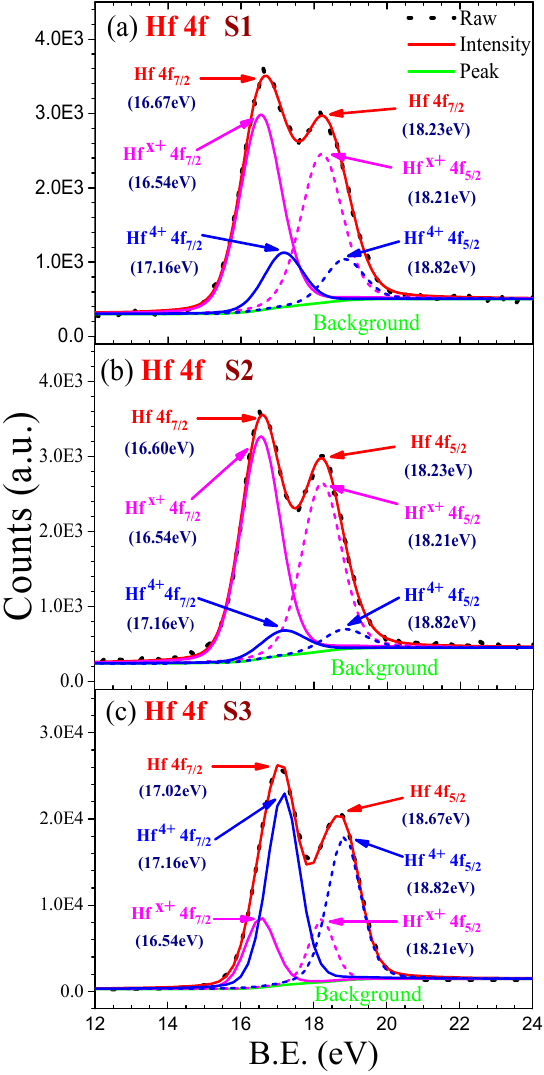
Figure 2. The high-resolution XPS fitting results of the Hf 4f peaks of S1, S2, and S3 are shown in ( a – c ), respectively, with experiment data (short dash lines), fitting result (red solid lines) and background (chartreuse solid lines).